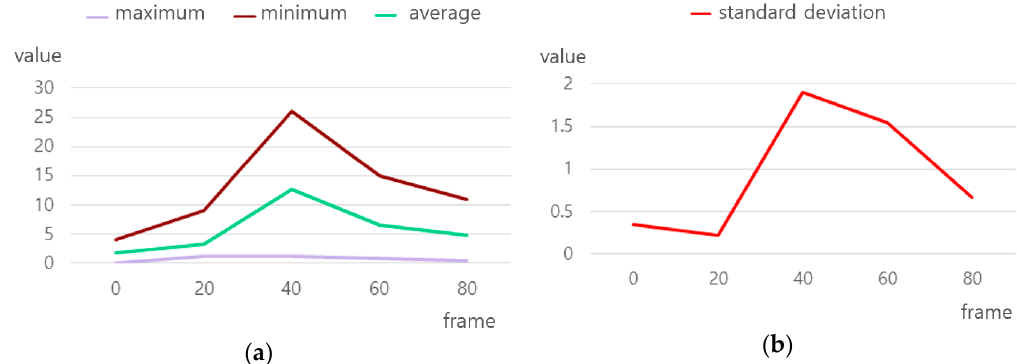
Figure 4. Statistical value of the motion vector. ( a ) Maximum, minimum, average; ( b ) standard Figure4. Statisticalvalueofthemotionvector. ( a )Maximum, minimum, average; ( b deviation.